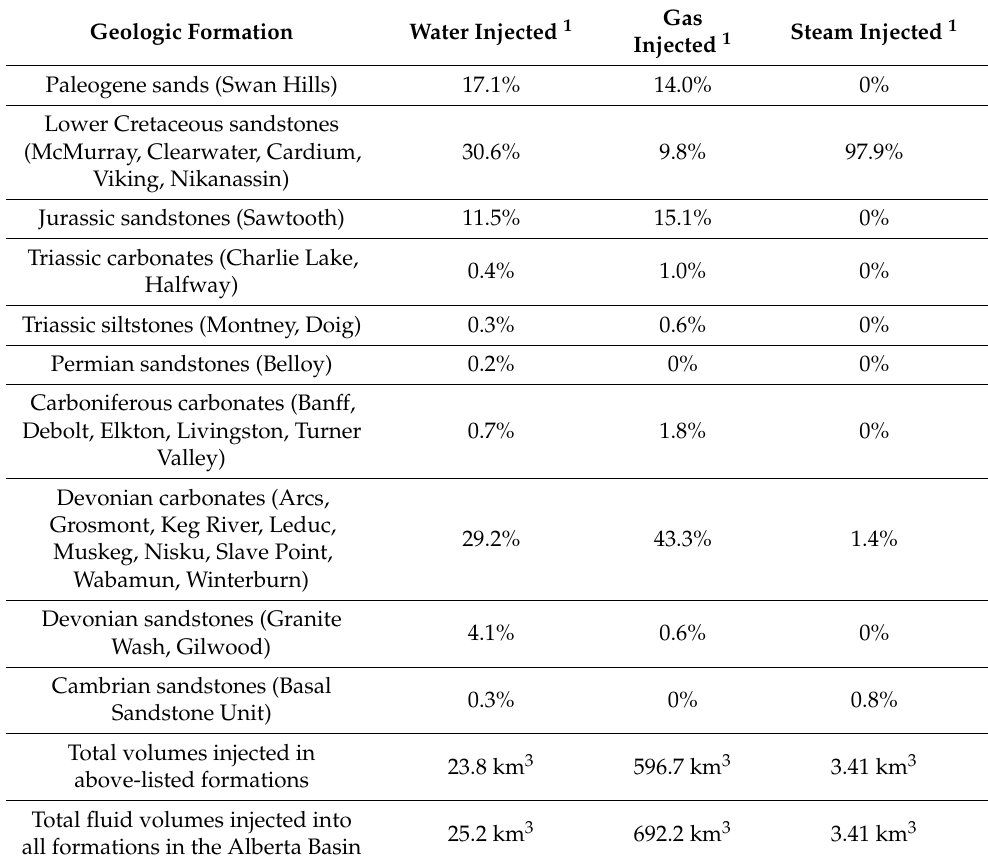
Gas Steam Injected 1 Injected 1